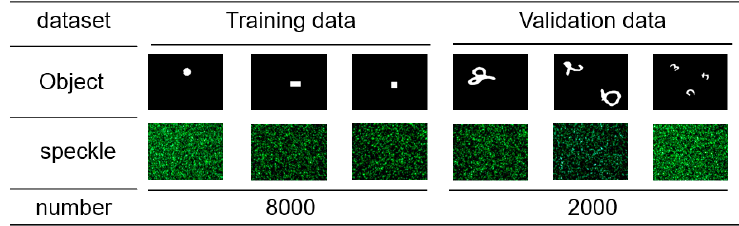
Figure 7. Example of experimental acquisition data.